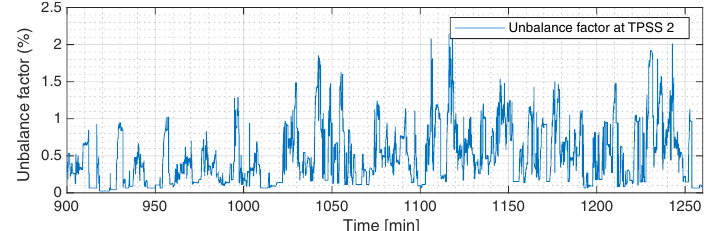
Figure 20. Voltage unbalance factor profile at TPSS 2, in case study #2. The V UF profile ranges from zero to around 2%. As in case study #1, the occurrence of very different levels for V UF can be better visualized with a histogram of the results, shown in Figure 21 for the three substations, although they are not enough for a complete characterization of this parameter.